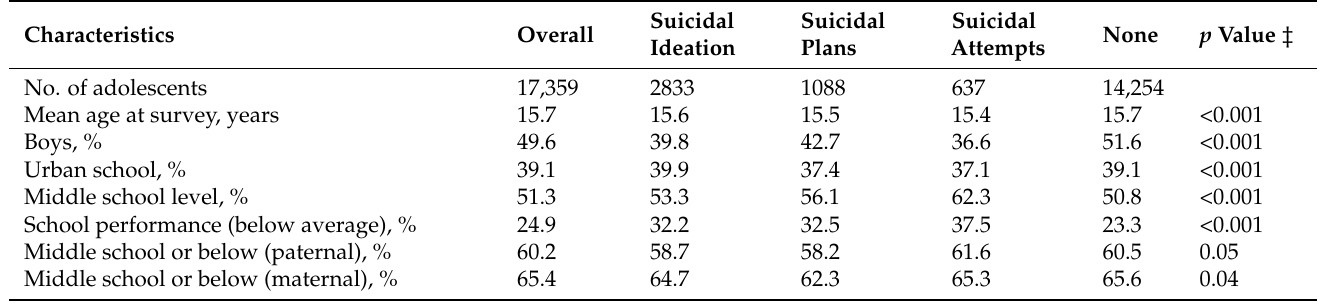
Table 1. Characteristics of study adolescents in Zhejiang Province according to suicidal ideation, plans and